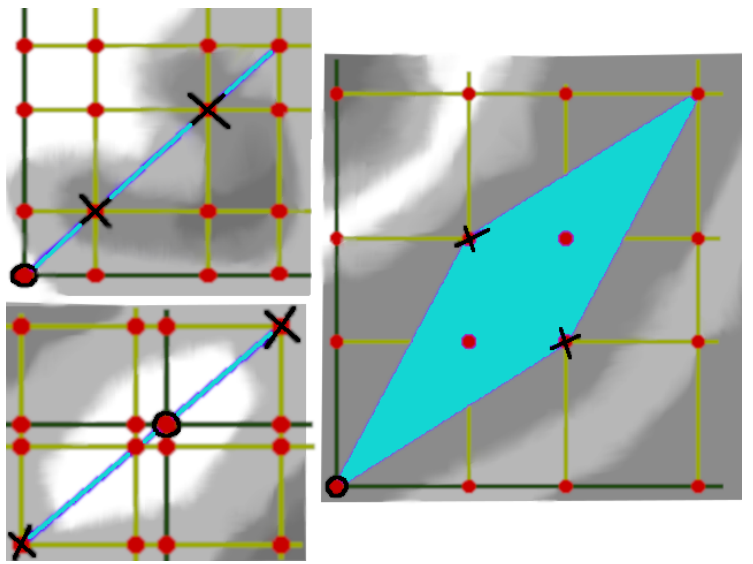
Figure 2. The difference between exploitation with PSO (blue envelope) and DPSO (red points on the